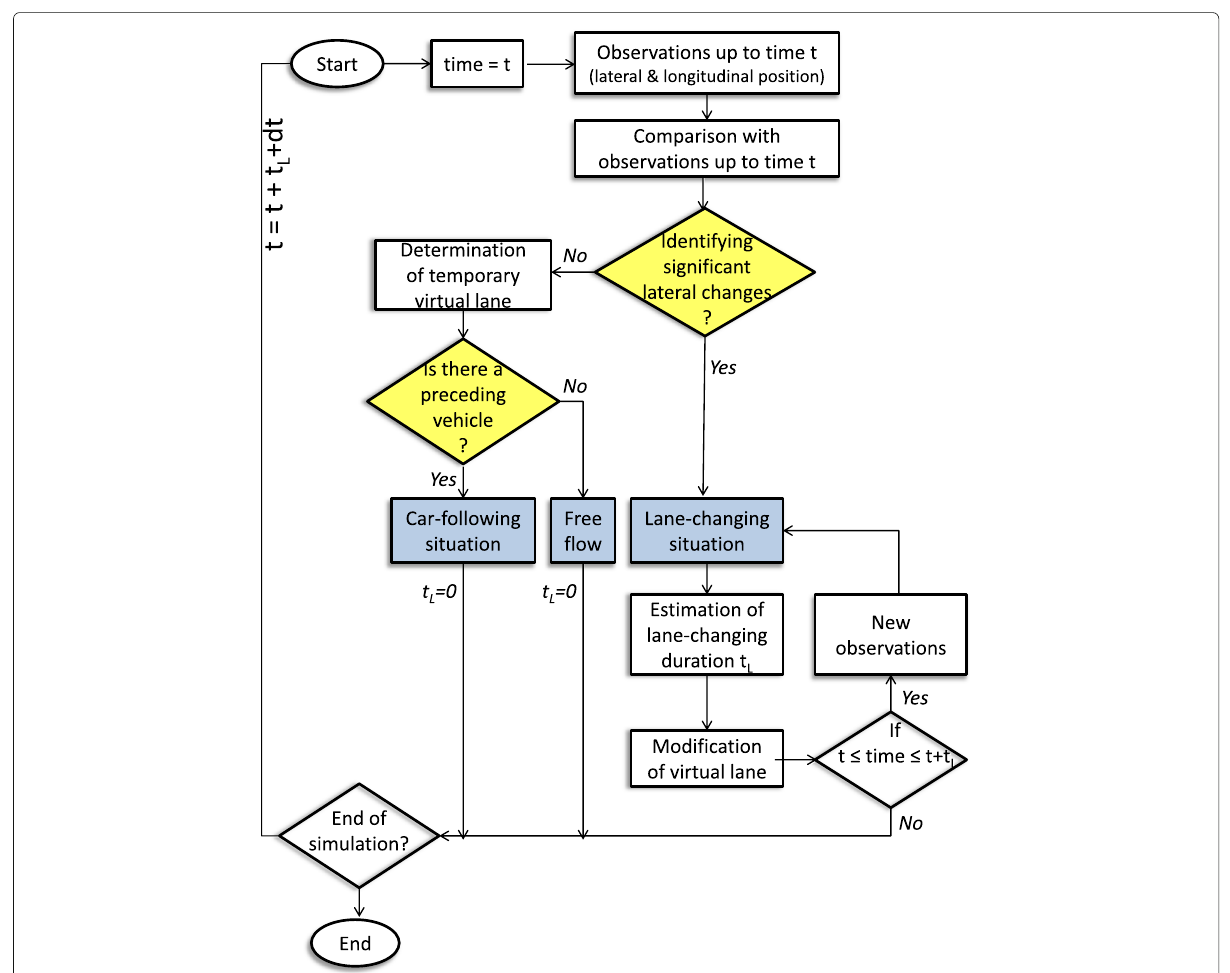
Fig. 4 Overall methodological approach